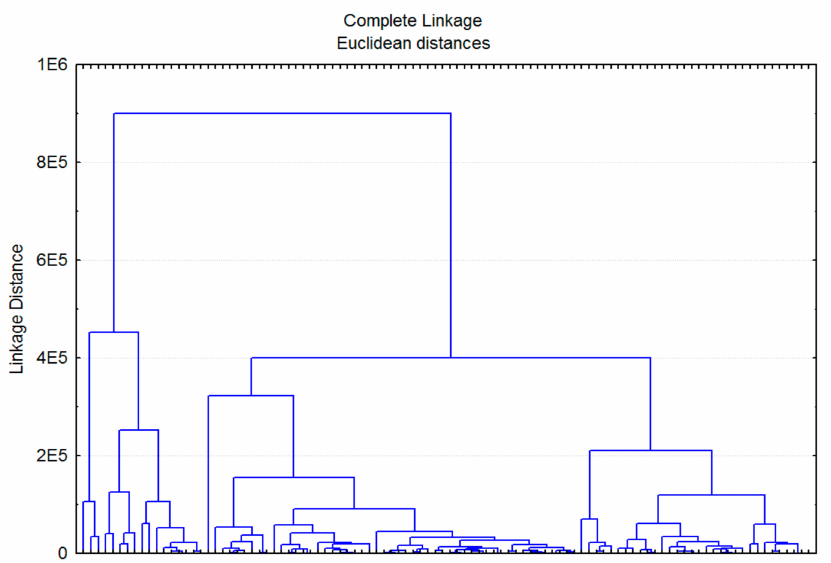
Figure 5. Dendrogram of hierarchical